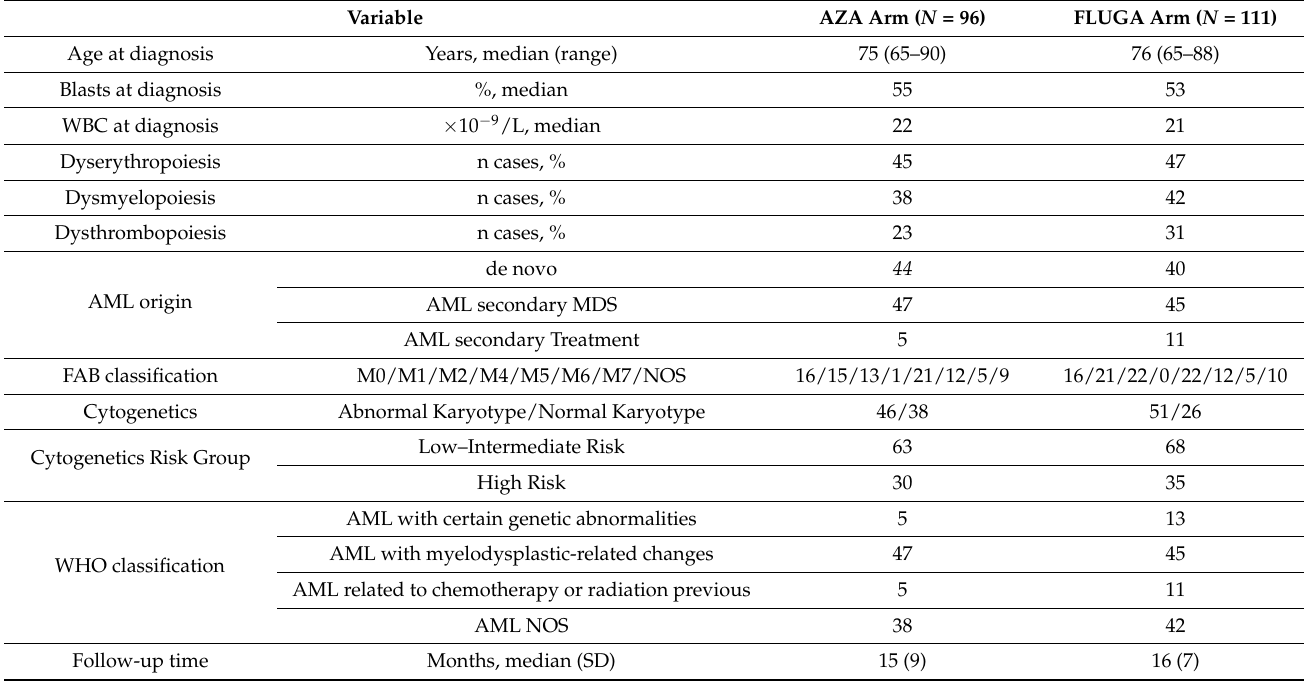
Table 1. Patient demographics and baseline